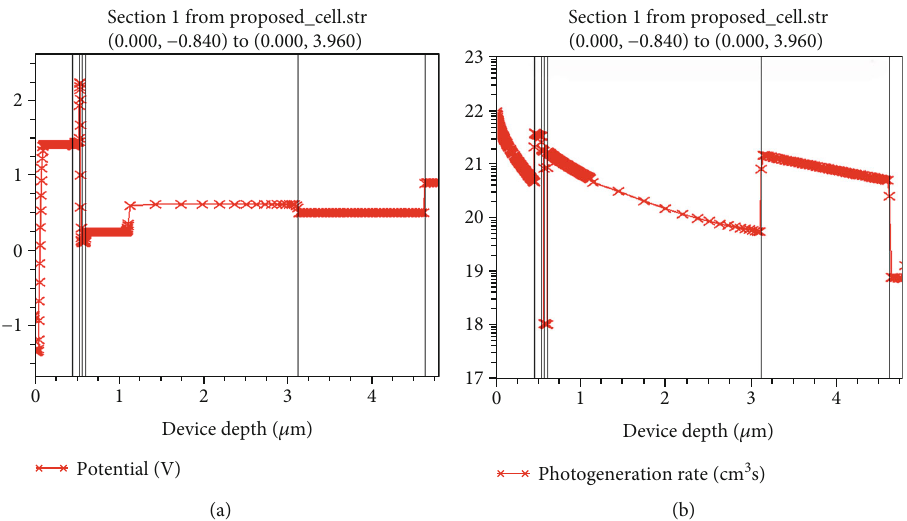
Figure 7: Cutline view of (a) electrostatic potential and (b) logarithmic distribution of the photogeneration rate in the cell.